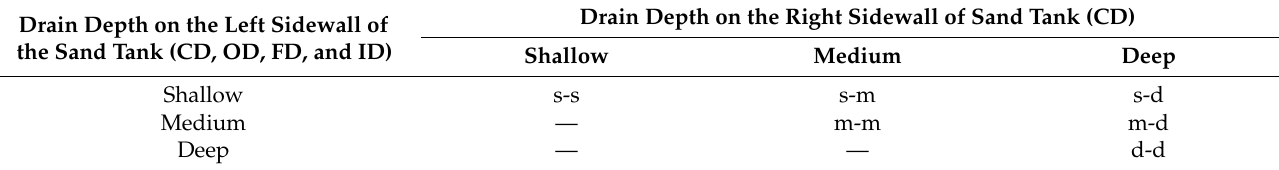
Table 1. Design scheme of the different combined drainage forms. Drain Depth on the Left Sidewall of the Sand Tank (CD, OD, FD, and